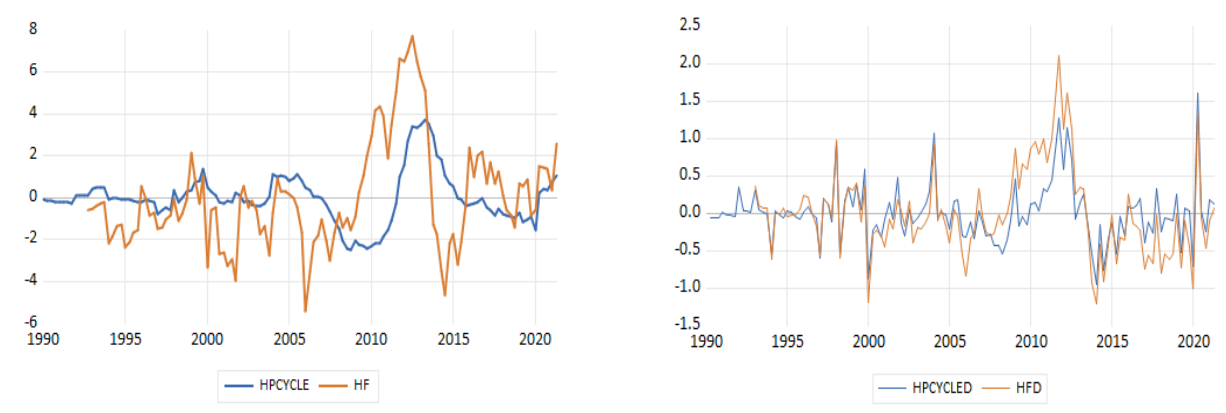
Figure 6. HP (1600) filter (blue) versus 2-year regression filter HF (brown), whole sample.